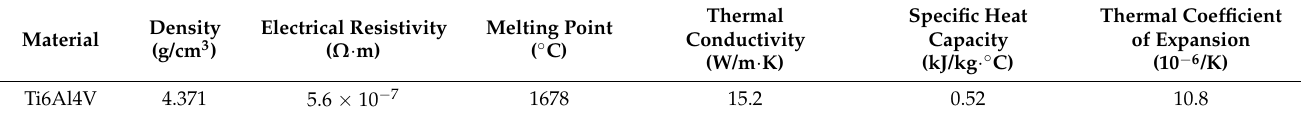
Table 1. Physical parameters of Ti-6Al-4V.